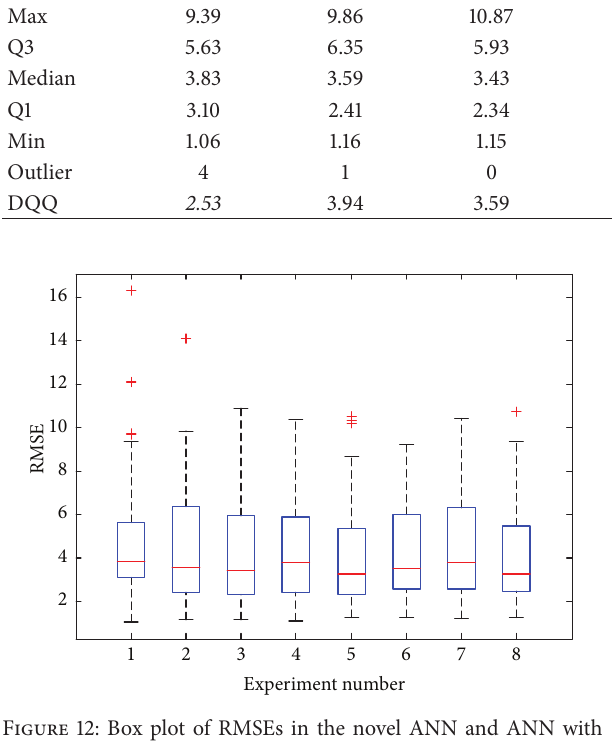
Table 6: Values of indicators in box plot of RMSEs in novel ANN and ANN with Bayesian regularization. Indicator